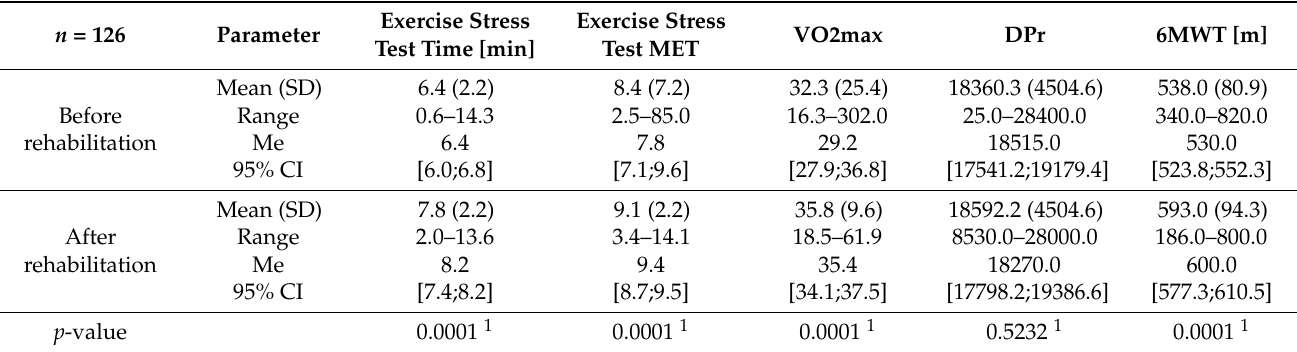
Table 3. Comparative characteristics of the examined group in terms of: exercise stress test time, exercise stress test MET, VO2max, DPr, and 6-min test measured at baseline and after rehabilitation.